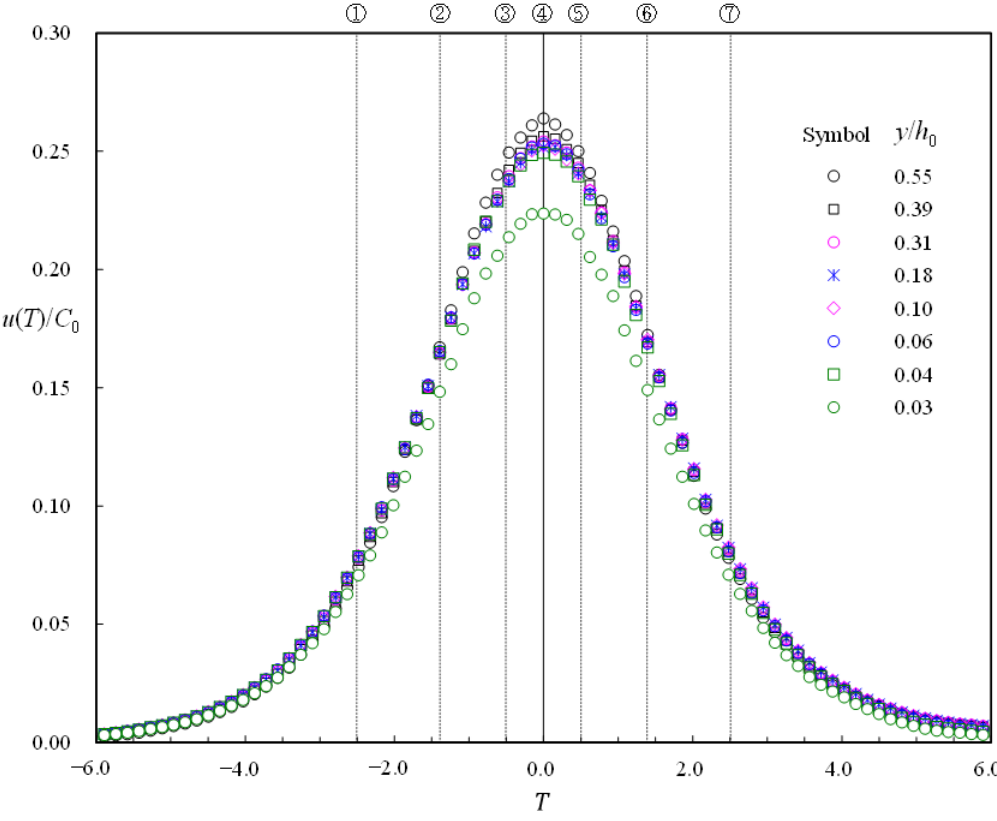
Figure 9. Temporal variation of u ( T )/ C 0 for y / h 0 = 0.03–0.55 (Case E).